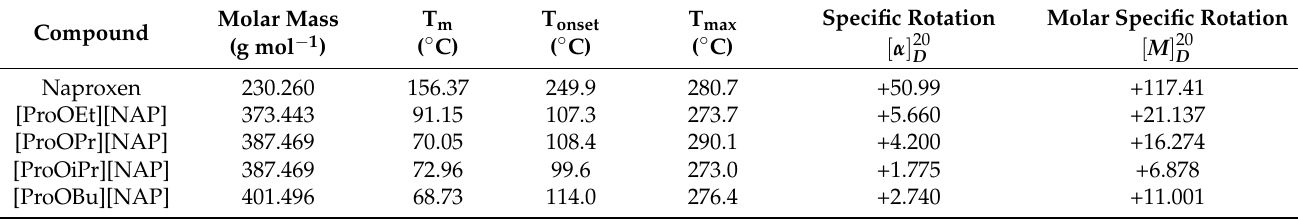
Table 2. The melting points, thermal stability, specific and molar rotation of naproxen and L-proline alkyl ester naproxenates.